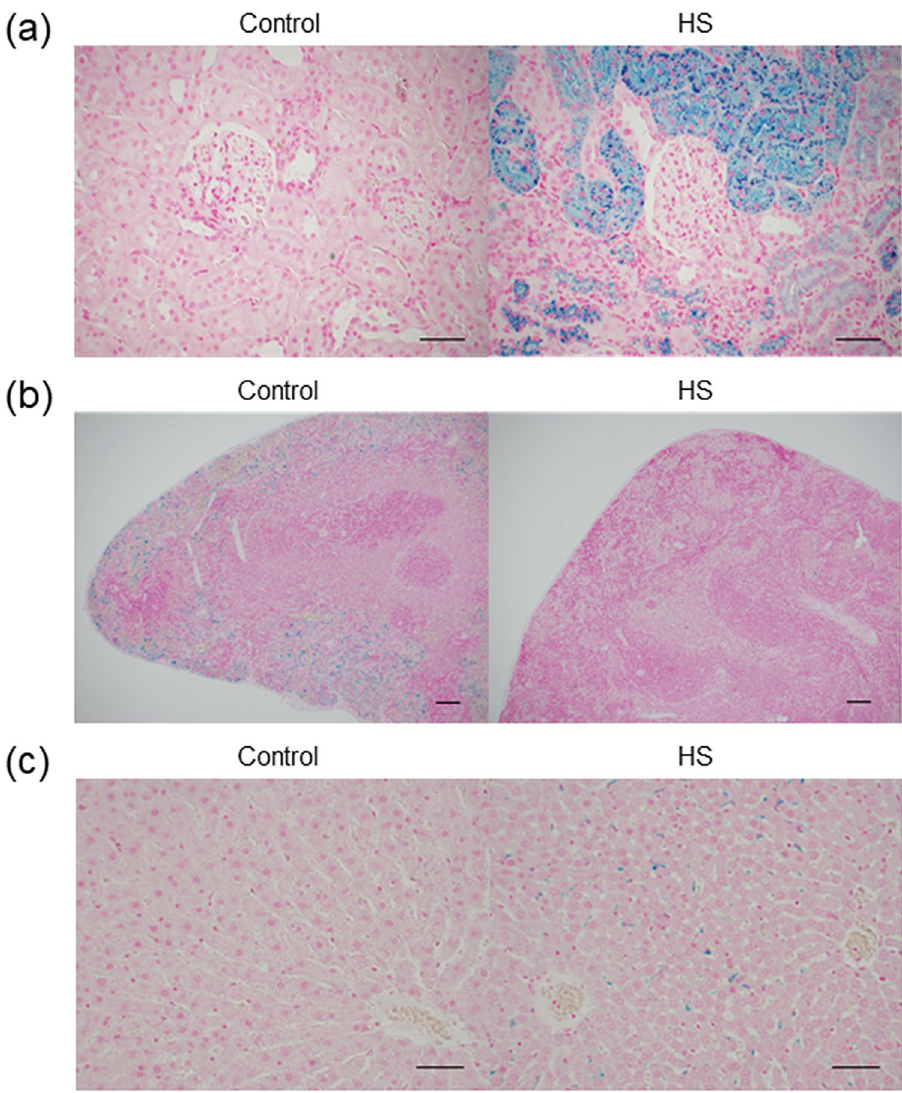
Figure 4. Tissue distribution of hemosiderin in Dahl/SS rats. Histological analysis of kidney ( a ), spleen ( b ) and liver ( c ) with Berlin Blue staining in the control and the HS groups. ( a , c ; bars 50 μm, b ; bars 100